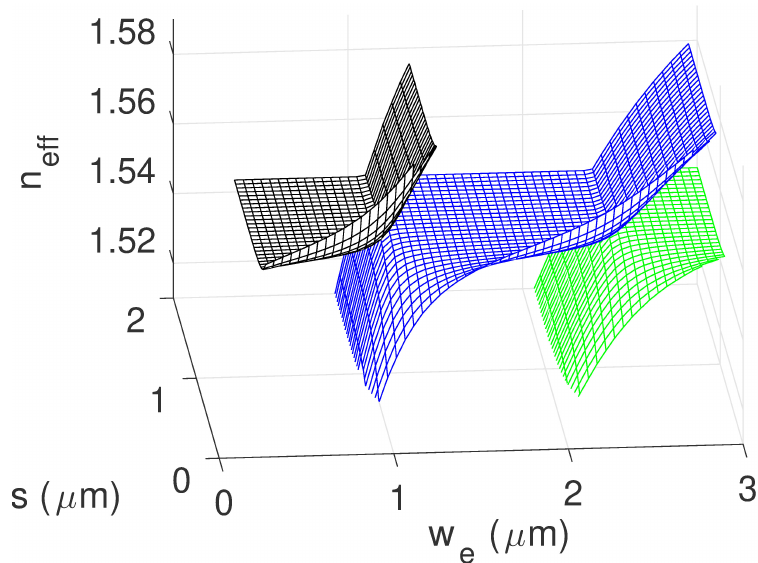
Figure 3. Effective indices of the TE modes propagating in the straight coupled asymmetric structure of Figure 2 as the two design parameters w e and s are varied. Three modes can be observed in the ( w e , s ) range depicted in the figure.